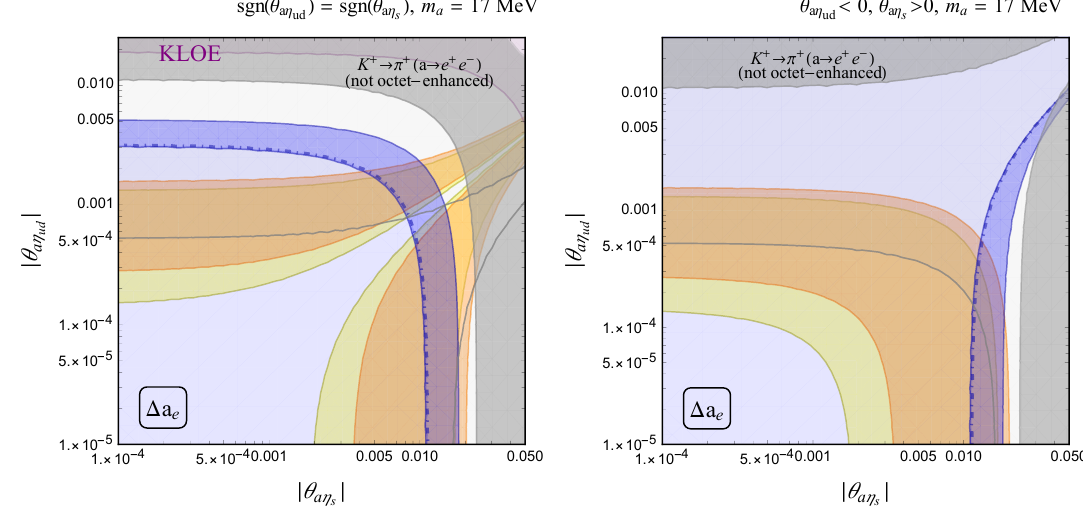
Figure 4 . Same parameter space as in figure 3 assuming that the correlation of g e and g aγγ is consistent with the Berkeley measuremant, ∆ a e , at the 95% CL. The bound from NA64 inferred from the central value of ∆ a e is shown in the red dashed